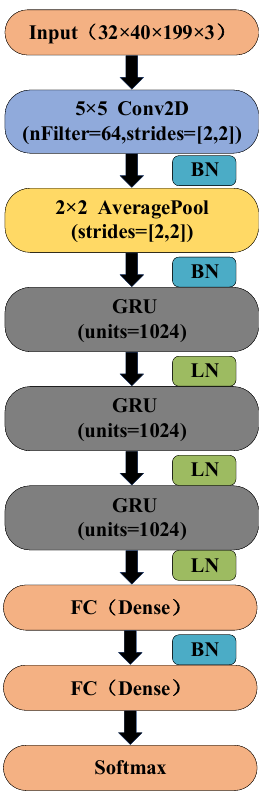
Figure 5. The architecture of the deep GRU network model, showing the input and some specific parameters of other layers, the framework is also the basis of code